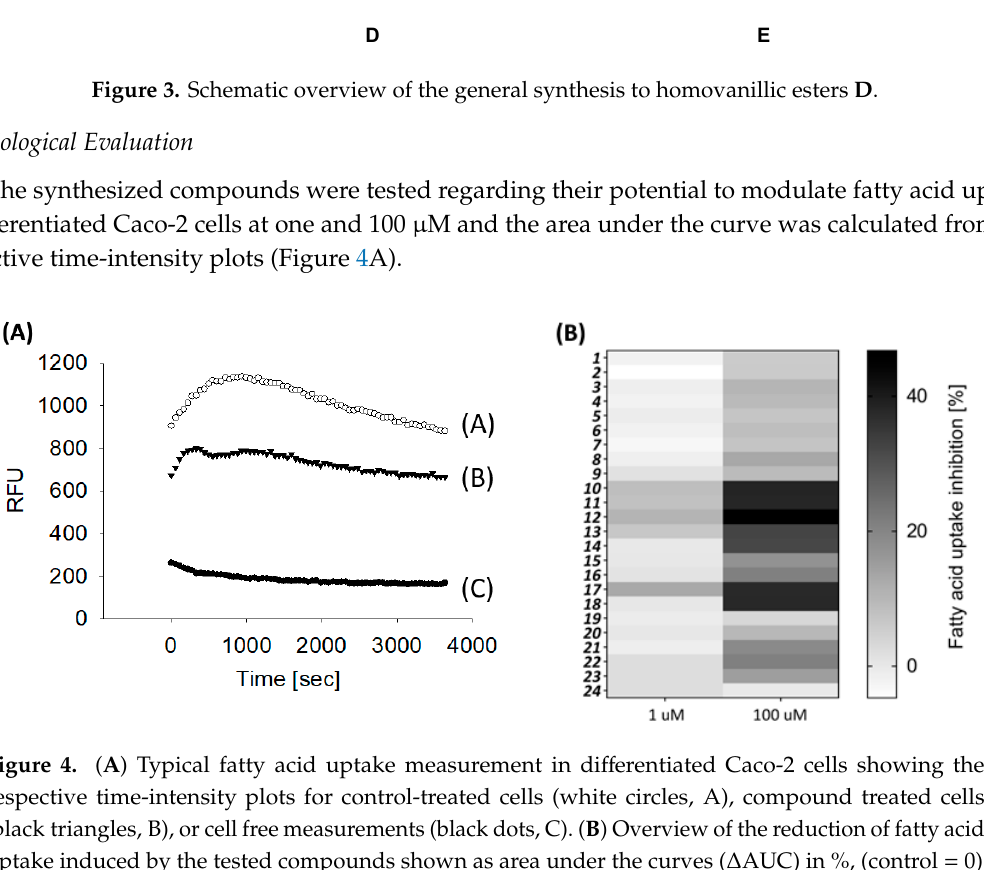
Figure 4. ( A ) Typical fatty acid uptake measurement in differentiated Caco ‐ 2 cells showing the respective time ‐ intensity plots for control ‐ treated cells (white circles, A), compound treated cells (black triangles, B), or cell free measurements (black dots, C). ( B ) Overview of the reduction of fatty